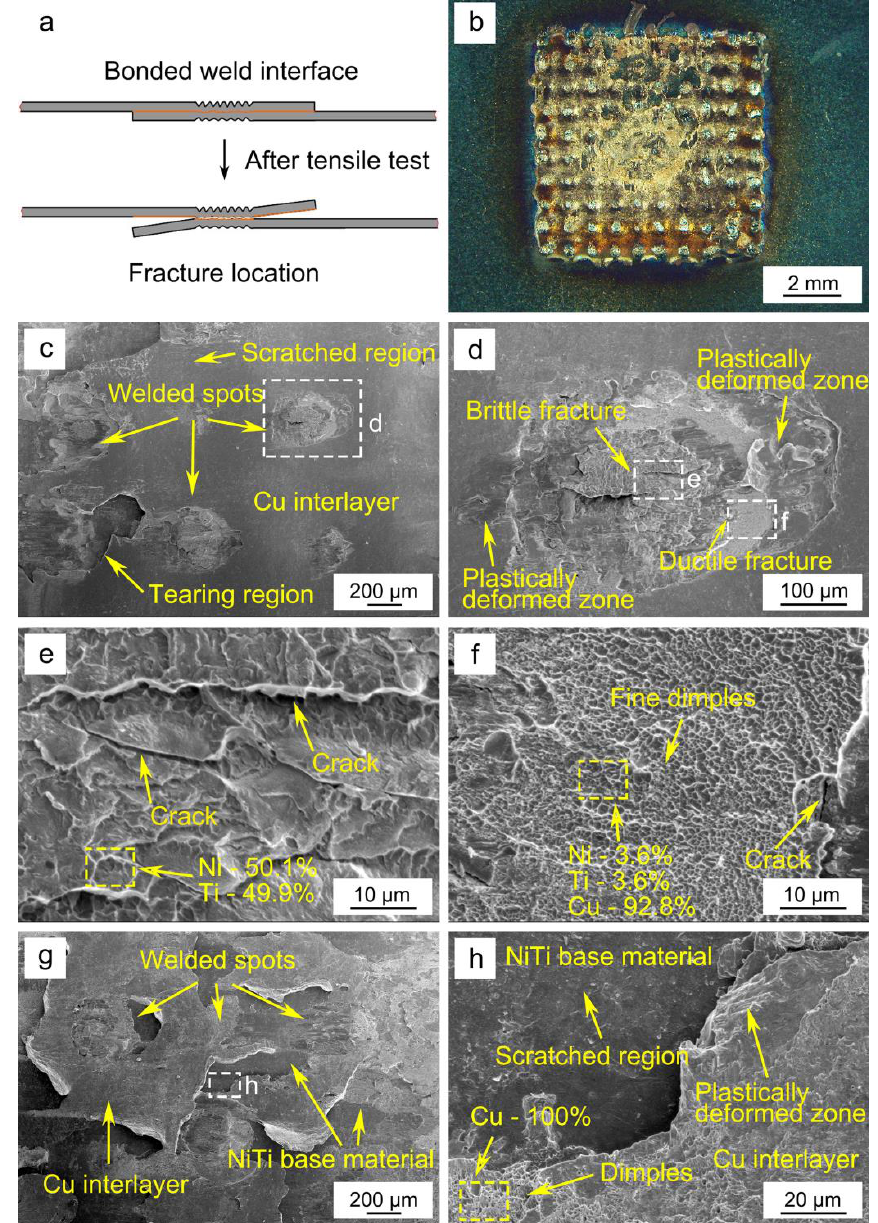
Figure 7. ( a ) Schematic diagram of fracture mode; ( b – h ) fracture morphologies of the tensile failed sample made at a welding energy of 1000 J; ( b ) overall view of fracture surface; ( c ) overall view of fracture surface by SEM; ( d ) magnified image of a weld spot depicted in ( c ); ( e , f ) magnified image of box in ( d ); ( g ) overall view of Cu interlayer on the fracture surface; ( h ) magnified image of box in ( g ).